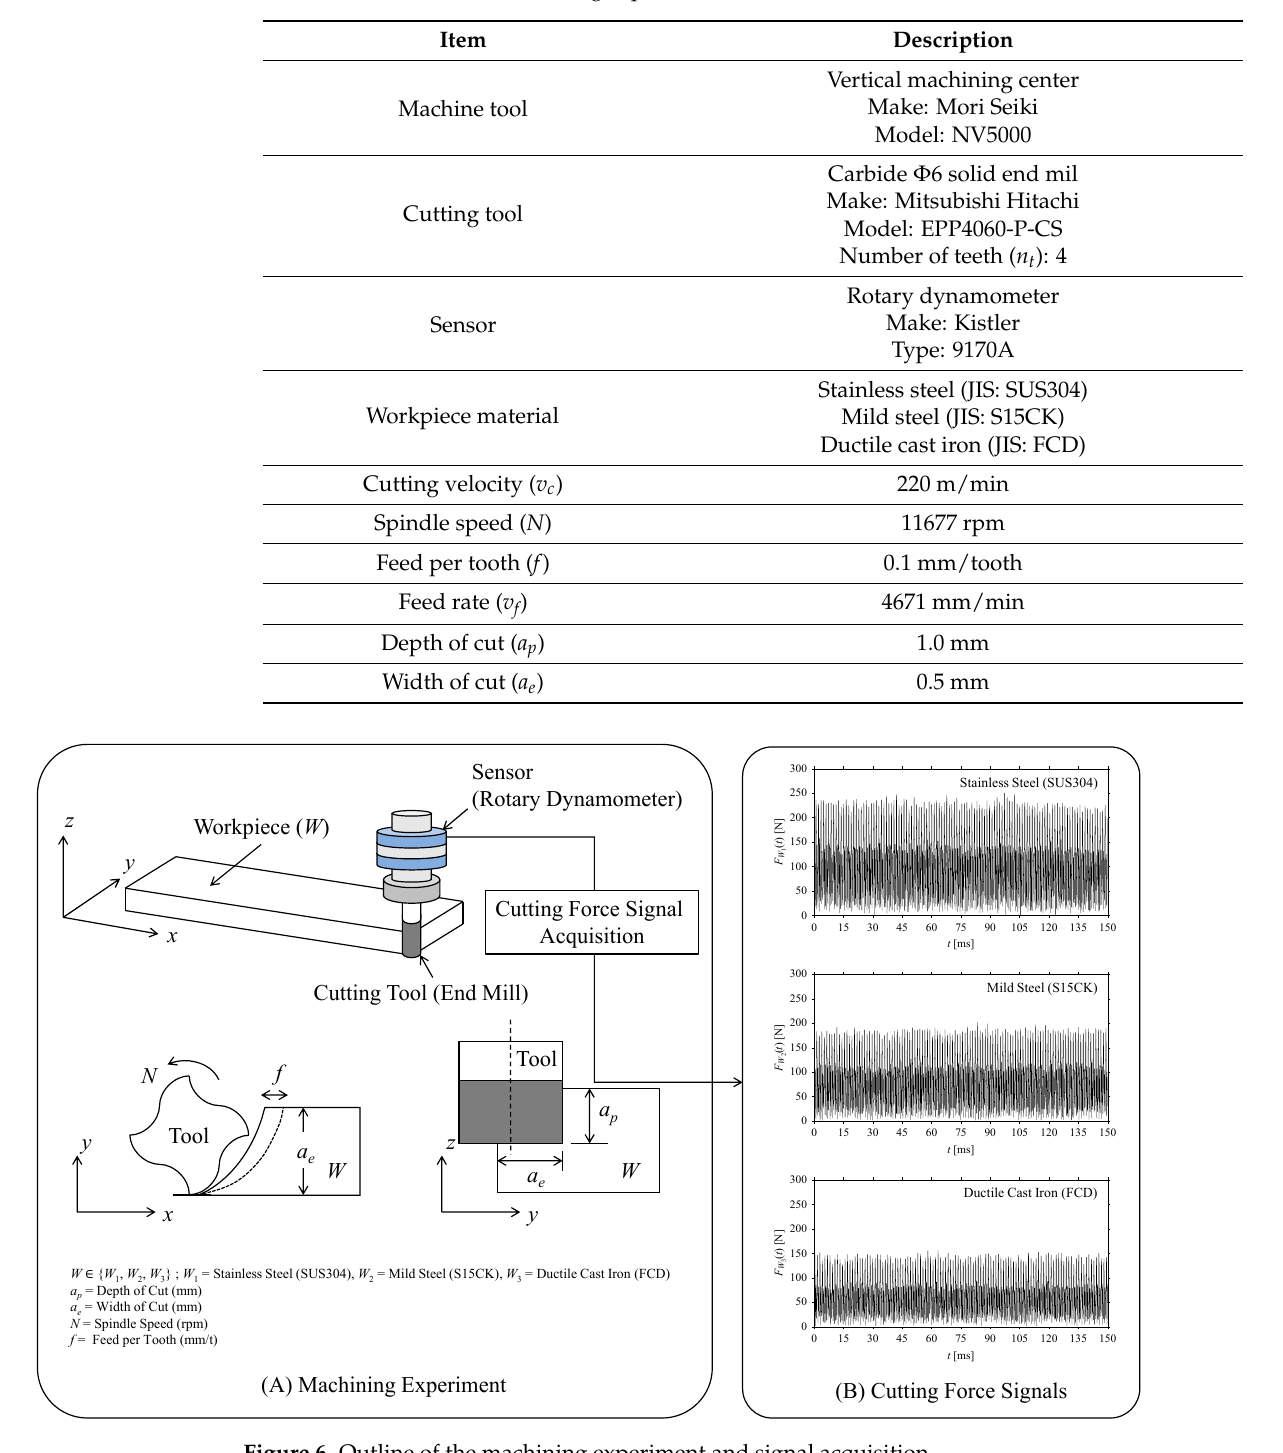
Figure 6. Outline of the machining experiment and signal acquisition.